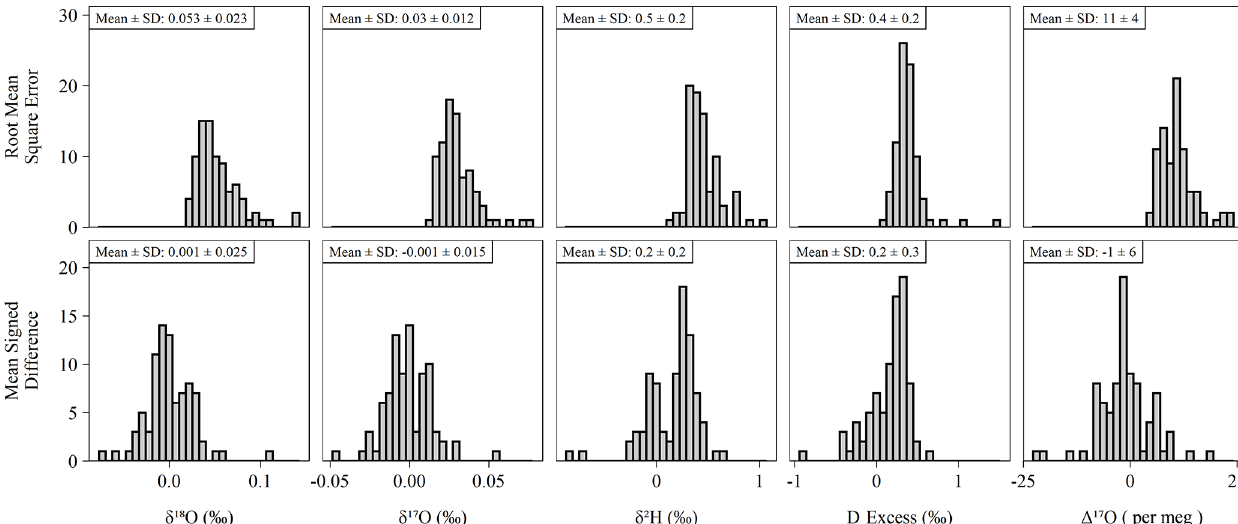
Figure 5. Histograms of accuracy metrics (see Sect. 2.3 for formulas) for all sequences ( n = 85) run during the study. Note that RMSE cannot be less than zero. Under ideal conditions, the mean MSD is equal to zero. Means and standard deviations (SD) shown above each histogram for each pairing of isotope measurement and accuracy